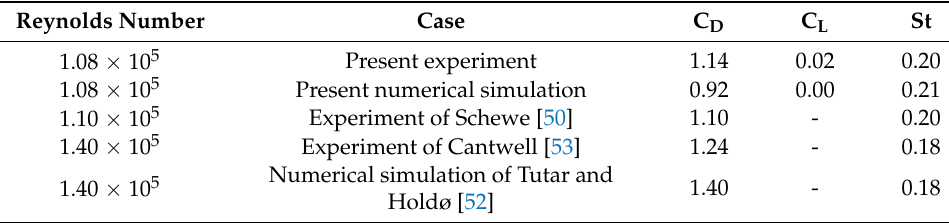
Figure 11. Mesh view of twin cylinder. Table 1. Results comparison of a single cylinder. Table 1. Results comparison of a single